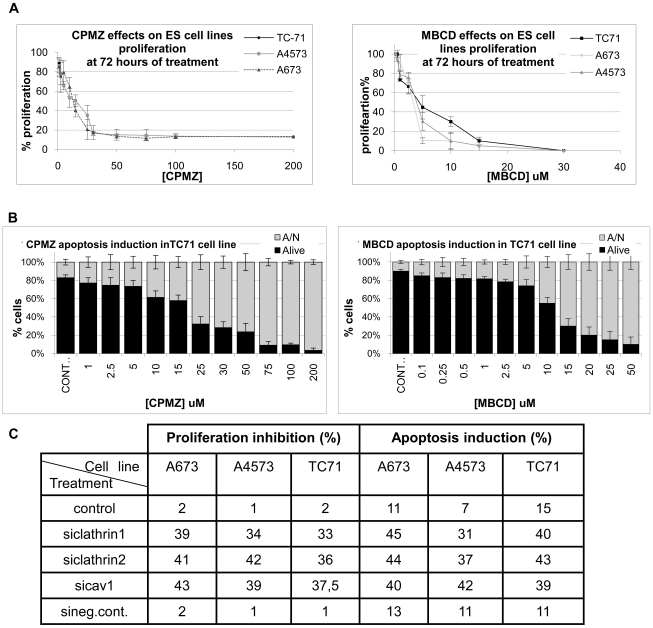
Effects of CAV1 or clathrin inhibition/interference in ES cell line proliferation and apoptosis.
A) CAV1 or clathrin inhibition reduced ES cell line proliferation in a dose-dependent manner with an IC50 of proliferation similar in all ES cell lines tested (between 10–15 µM for CPMZ and 4–4.5 µM for MCD). B) The results obtained regarding the induction of apoptosis were similar to those obtained with the inhibition of proliferation in all cell lines (A673 and A4573 data shown in SD figure S3). A/N: Apoptotic and Necrotic cells. C) CAV1 or clathrin siRNAs induced around 40% of the inhibition of proliferation and 40–45% of apoptosis induction. Data presented as the average of 4–6 independent replicates.